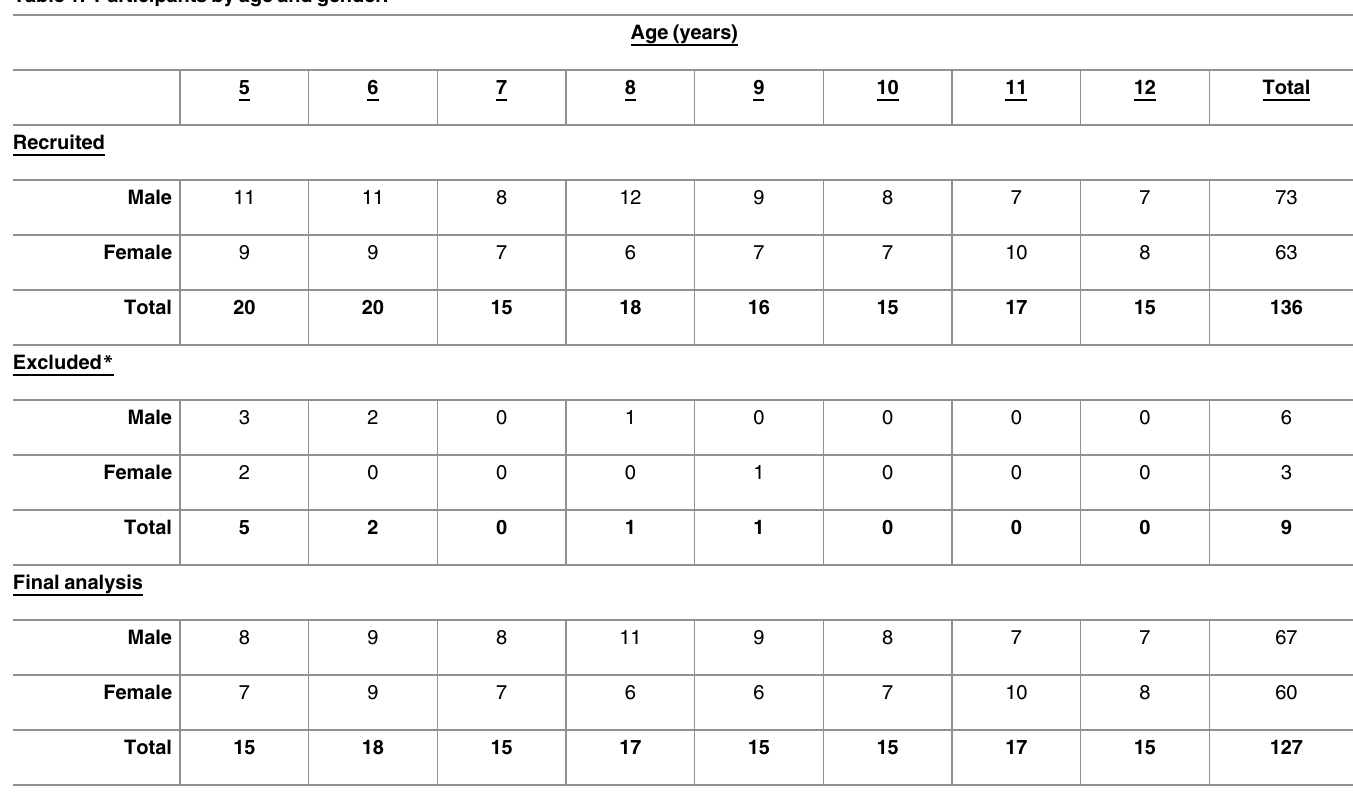
identities (Identity A/Identity B). After a delay (400ms), the target face is replaced by two choice faces: 100% Identity A and 100% Identity B. A total of 4 male and 4 female identities were used to create 4 morph continuums (2 male continuums, 2 female continuums, Fig 1B). neutral facial expressions. The child was asked to pick the choice face that is most similar to the target identity by pressing an arrow key (left arrow = face on the left, right arrow = face on the right). The experimenter emphasized that the child should do his or her best to choose the “correct” face and not be concerned about speed. The children were not told that there was no correct answer in the 50% morph trials. The Expression task is matched in format and diffi-